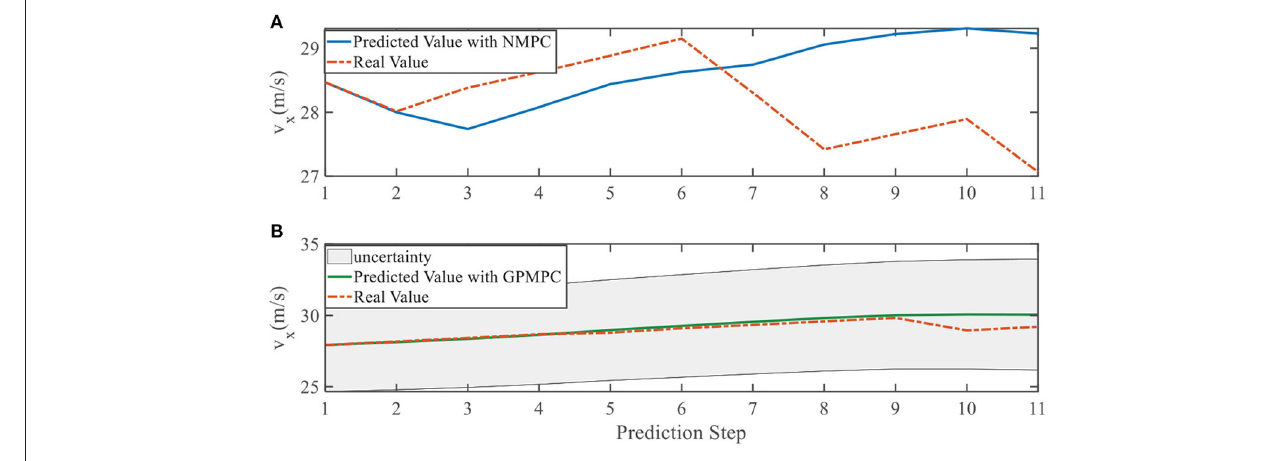
FIGURE 10 | Velocity v x evolution in left overtaking. (A) NMPC; (B) GPMPC.